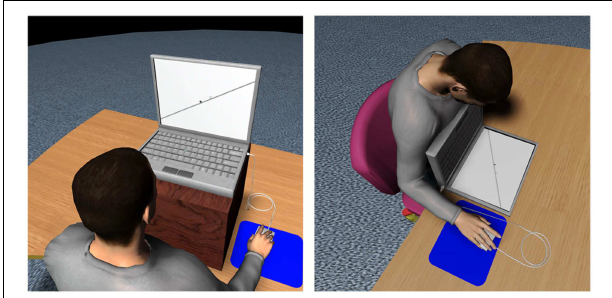
FIGURE 1 | Illustration of the vertical (left) and horizontal (right) Motion plane conditions, for objects traveling onto a + 30 ◦ slope surface.